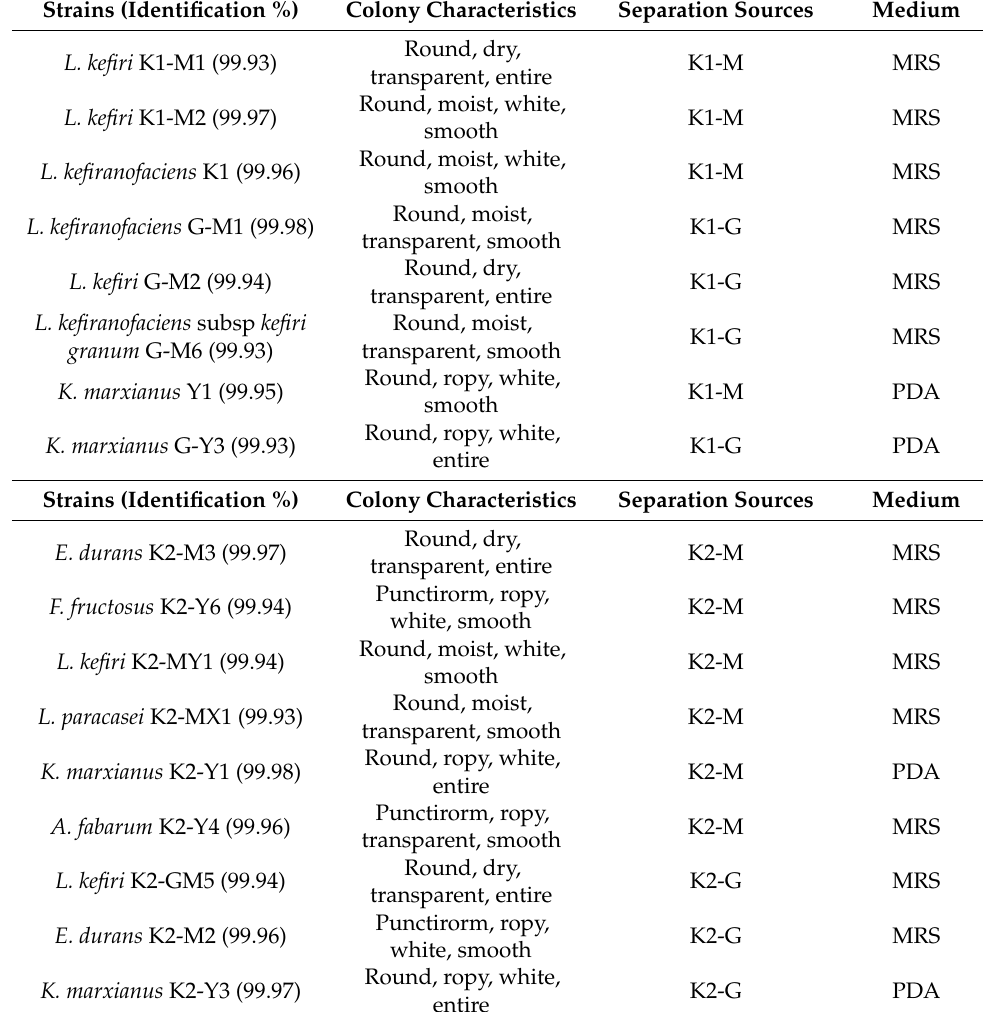
Table 2. Strains isolated from K1 and